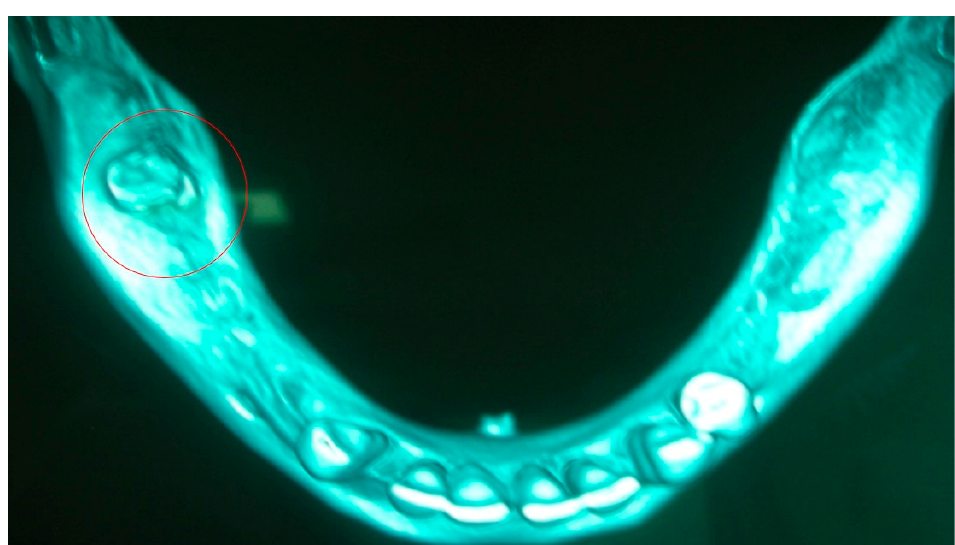
Figure 9. CBCT of the initial lesion pointed by the circle.